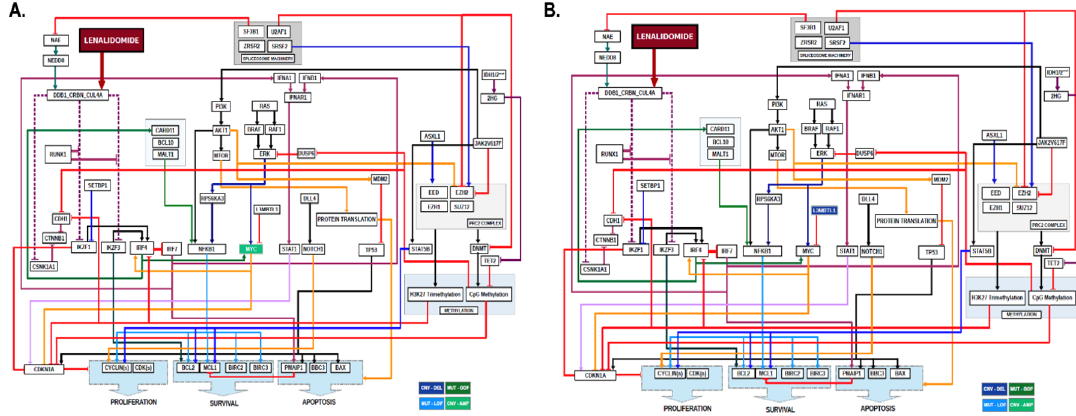
Figure 3. Computational Models of Non-Del(5q) MDS Patients with Abnormal Karyotype. MDS patient-specific gene copy number variations derived from karyotype result were computationally modeled and lenalidomide treatment digitally simulated. Two-dimensional maps showing intracellular pathways show the mechanisms of lenalidomide sensitivity in non-del(5q) MDS patients with ( A ) trisomy 8 karyotype and ( B ) del(20q) karyotype. Arrowed lines indicate agonistic relationship. Barred lines indicate antagnostic relationship. Line colorations are to assist the human eye in discriminating among the pathways. Somatic genes in dark blue boxes indicate copy number variation (CNV) deletions (DEL) derived from cytogenetic abnormalities. Somatic genes in light green indicate CNV amplifications (AMP) derived from cytogenetic abnormalities. Somatic genes with mutations resulting in loss of function (LOF) are indicated in light blue boxes. Somatic genes with mutations resulting in gain of function (GOF) are indicated in dark green boxes.